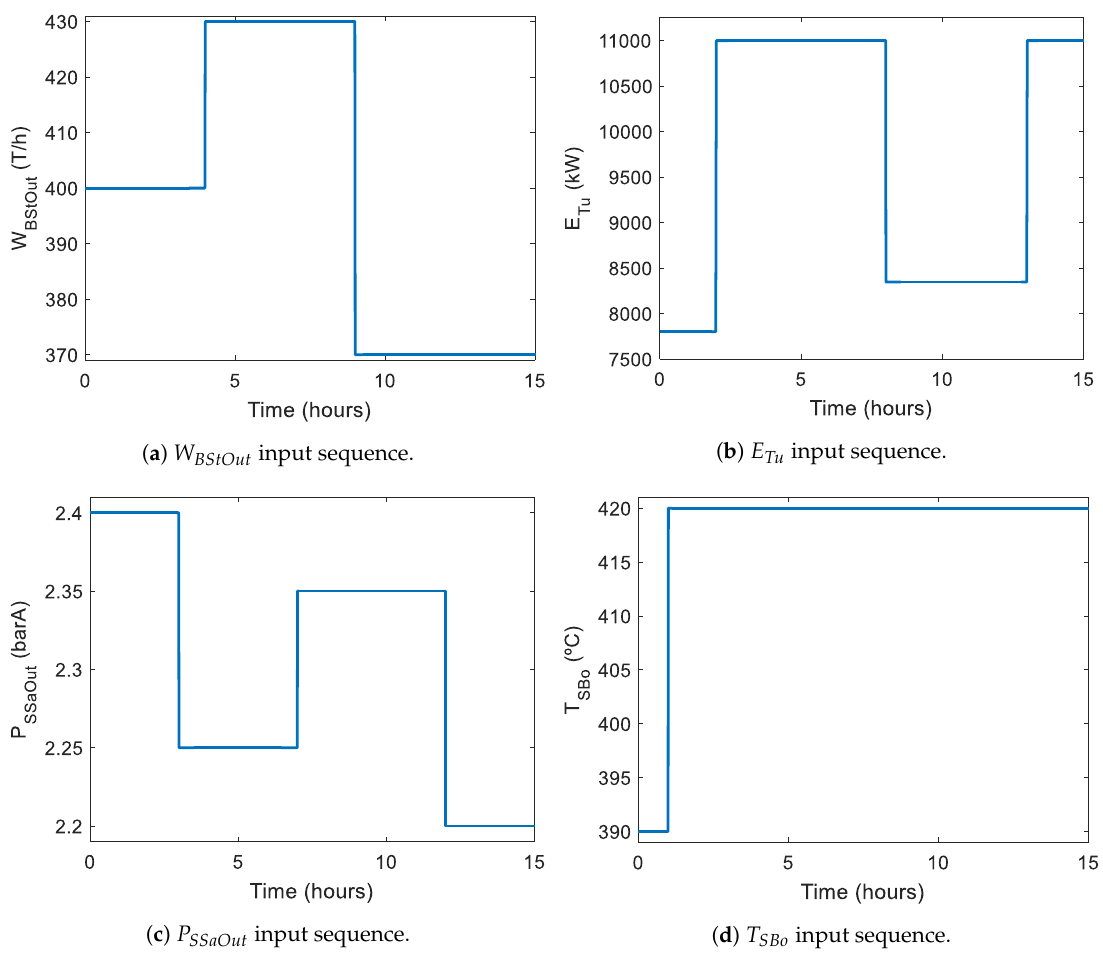
Figure 10. Inputs for